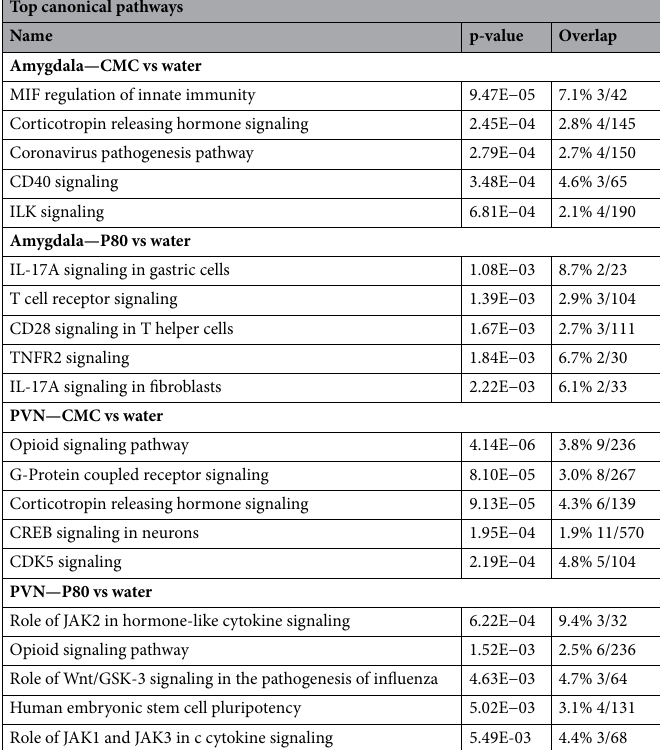
Table 3. Top five IPA enriched canonical pathways of differentially expressed genes in the amygdala and PVN of emulsifier treated mice. Emulsifier-treatment is primarily associated with inflammation and other immune- related canonical pathways. The top categories were ranked in accordance with their P-value of overlap. Overlap refers to the number of molecules from the dataset that map to the pathway listed divided by the total number of molecules that define the canonical pathway from within the IPA